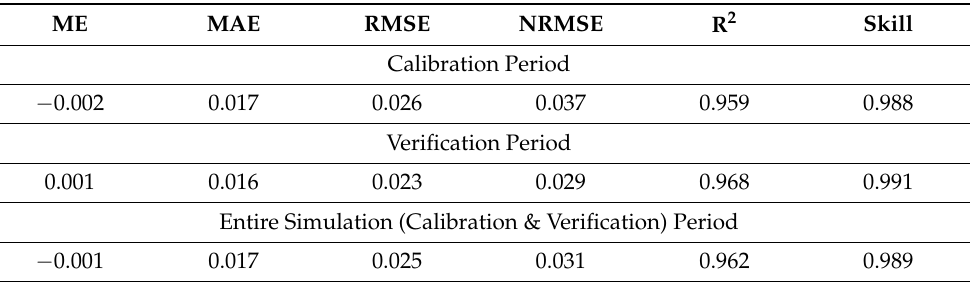
Table 5. MEs, MAEs, RMSEs, NRMSEs, R 2 values, and skills simulated discharges (m 3 /s) in com- parison with real-time field data measured at the CRC station during the calibration period, the verification period, and the entire simulation